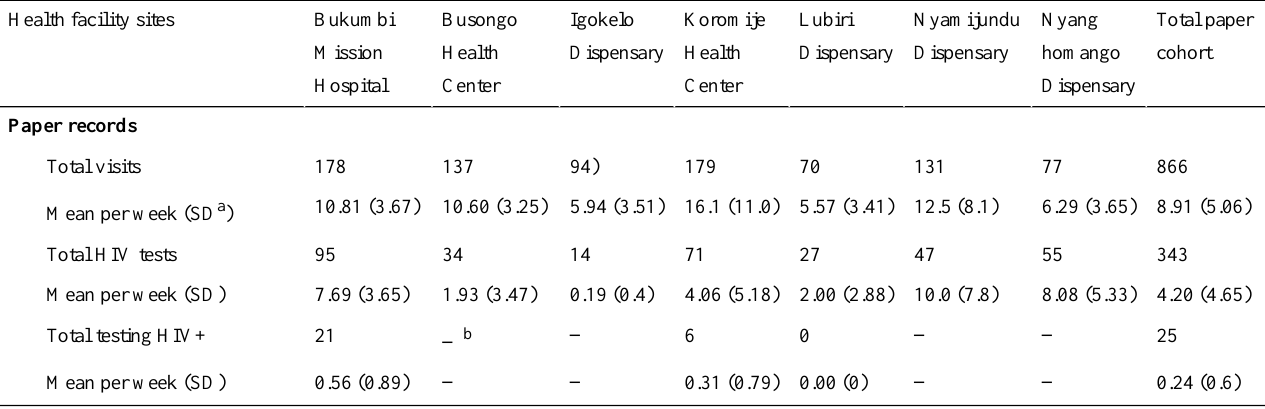
Table 2. Antenatal visit information at comparison health facility sites, intervention